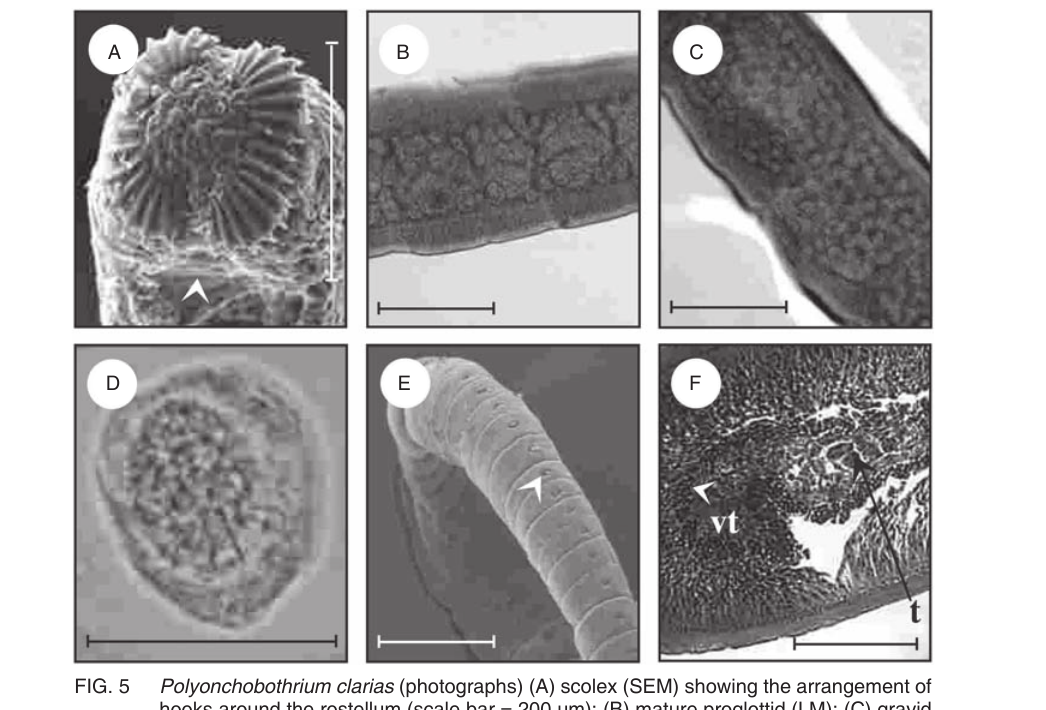
FIG. 5 Polyonchobothrium clarias (photographs) (A) scolex (SEM) showing the arrangement of hooks around the rostellum (scale bar = 200 μ m); (B) mature proglottid (LM); (C) gravid proglottid (LM) (scale bars = 400 μ m); (D) embryonated egg (LM) (scale bar = 50 μ m); (E) strobila (SEM) showing genital openings (go) and fused segment (fs) on the ventral surface; (F) light micrographs of AZAN stained transverse section through early mature proglottid (scale bar = 60 μ m), t = testes, vt = TABLE 4 Ornithodiplostomum sp. measurements ( μ m) n =